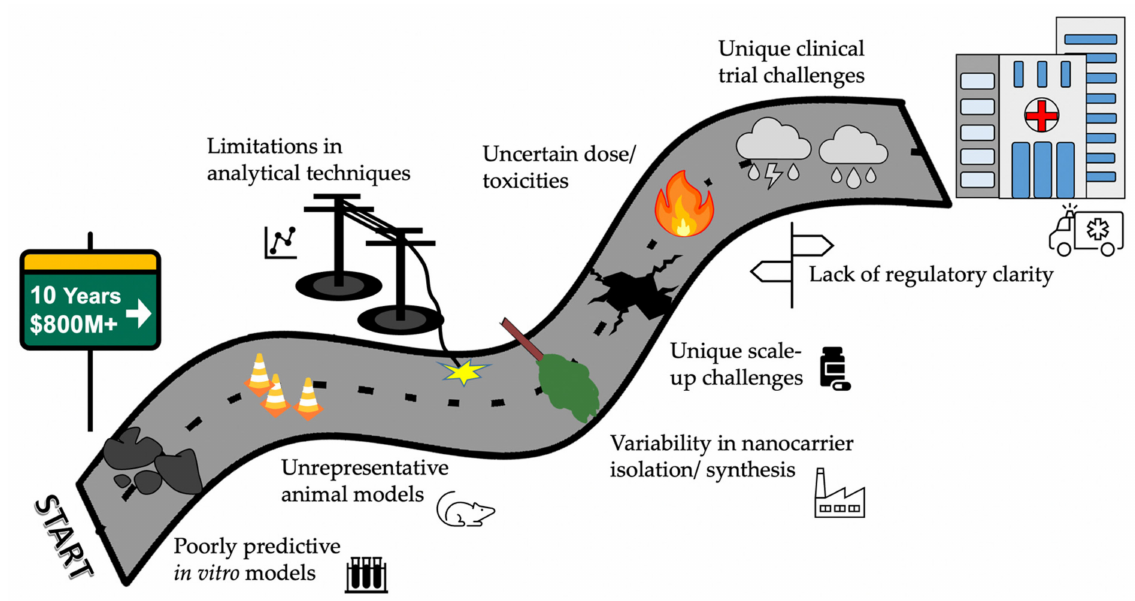
Figure 3. The road to clinical translation of nanomedicines for brain drug delivery contains many obstacles. Scaling up a nanocarrier technology from research/publication-grade to a commercial product in clinical trials is fraught with challenges. Under optimal conditions, it may take five years to reach clinical trials and the best part of a decade to reach full clinical use. Some of the common obstacles are illustrated in the schematic diagram, but this is not an exhaustive list. Many publications rely on poorly predictive in vitro models such as brain endothelial cell monolayers, or unrepresentative animal models such as xenografts. There are serious limitations in measuring nanocarrier distributions and brain uptake, especially in pre-clinical studies. Variability liposome manufacture, or exosomes isolation, also produces heterogenous final products. All pre-clinical products face challenges in scale up from the lab bench, but nanocarriers face many additional hurdles. One of the largest is the regulatory uncertainty, including unclear criteria for determining batch consistency and bioequivalence. Finally, there are unique clinical trial challenges, including the inability to sample brain tissue to quantify drug